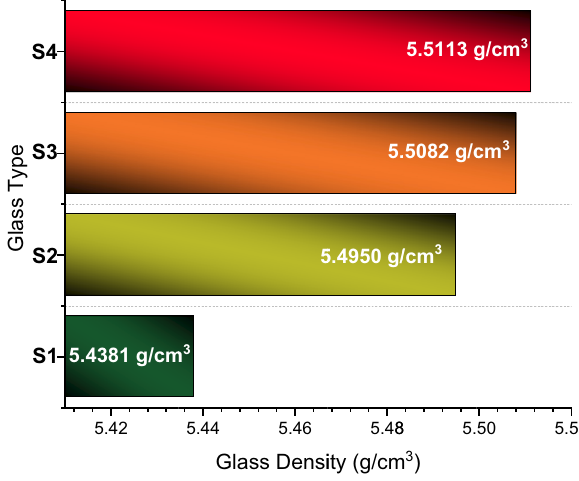
Figure 2: Variation in investigated glass densities ( g/cm 3 )